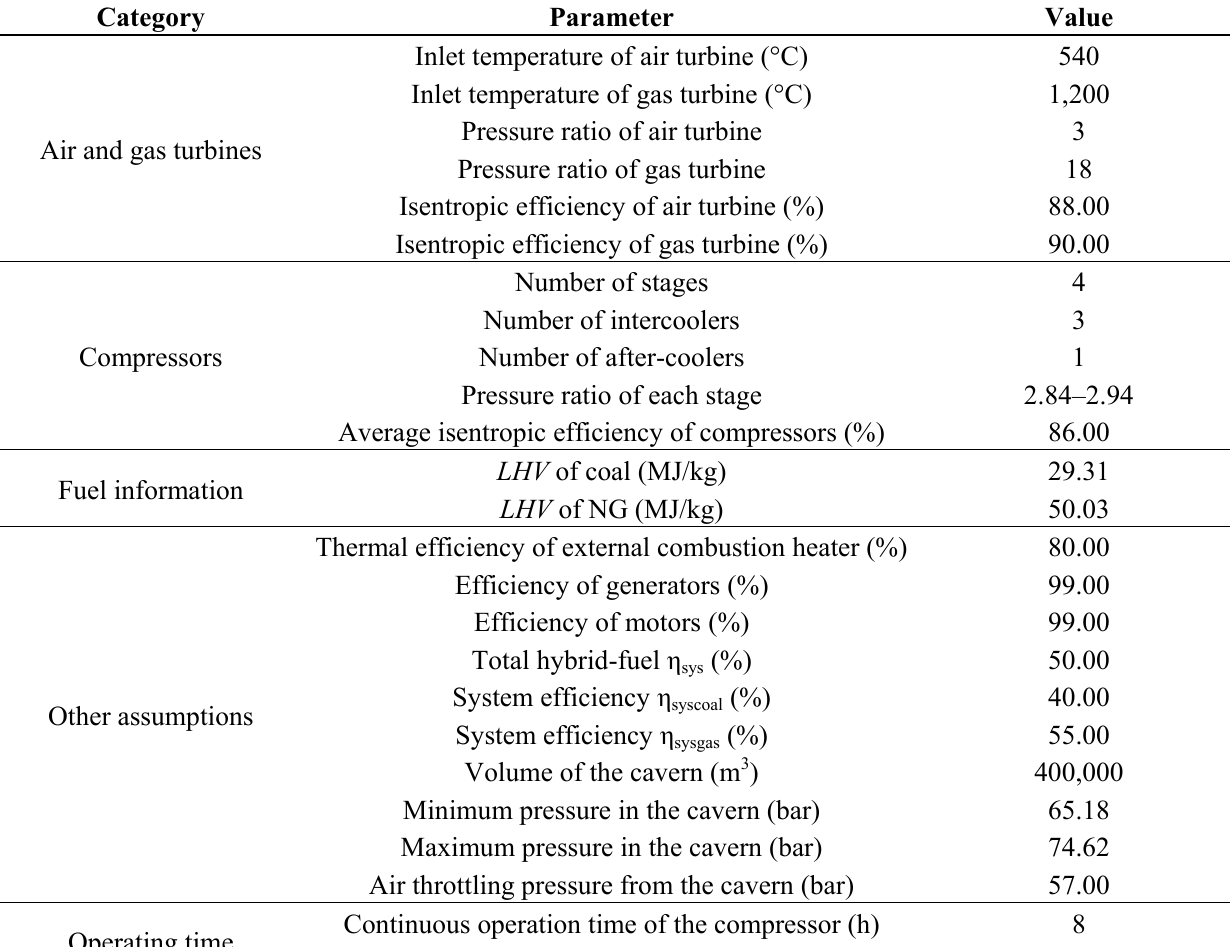
Table 1. Basic conditions and assumptions for simulation. LHV : lower heating value; and NG: natural